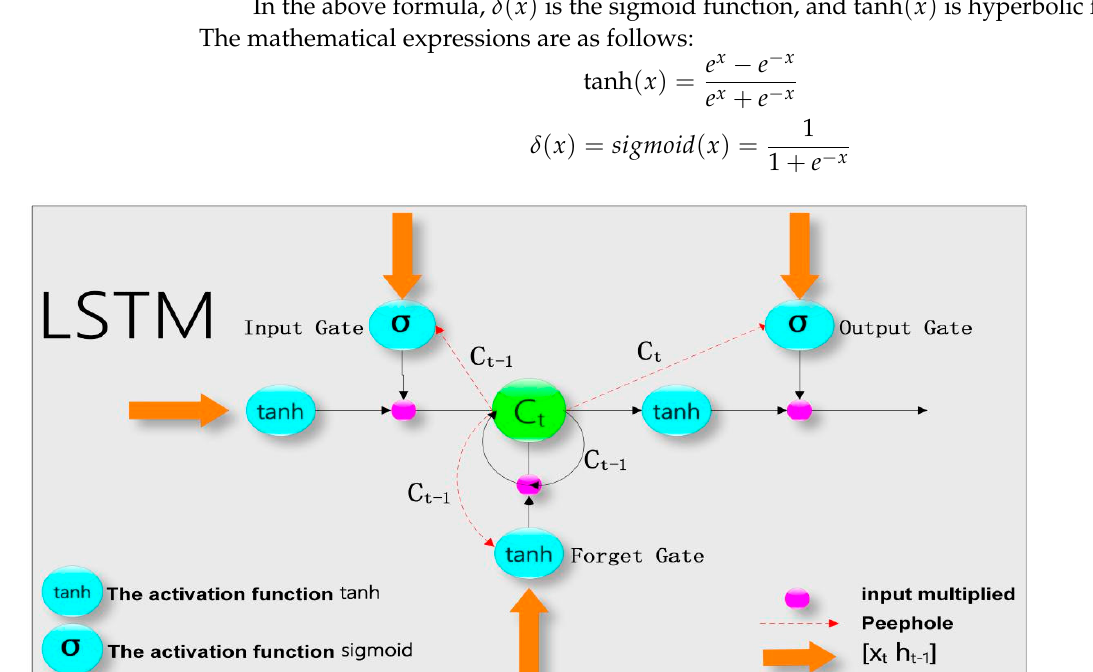
Figure 1. The structure of the LSTM neural network.